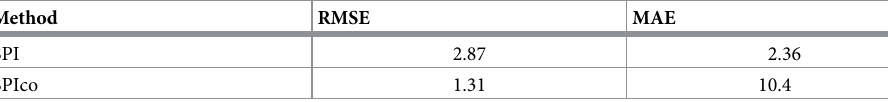
Table 7. Comparison of traffic congestion